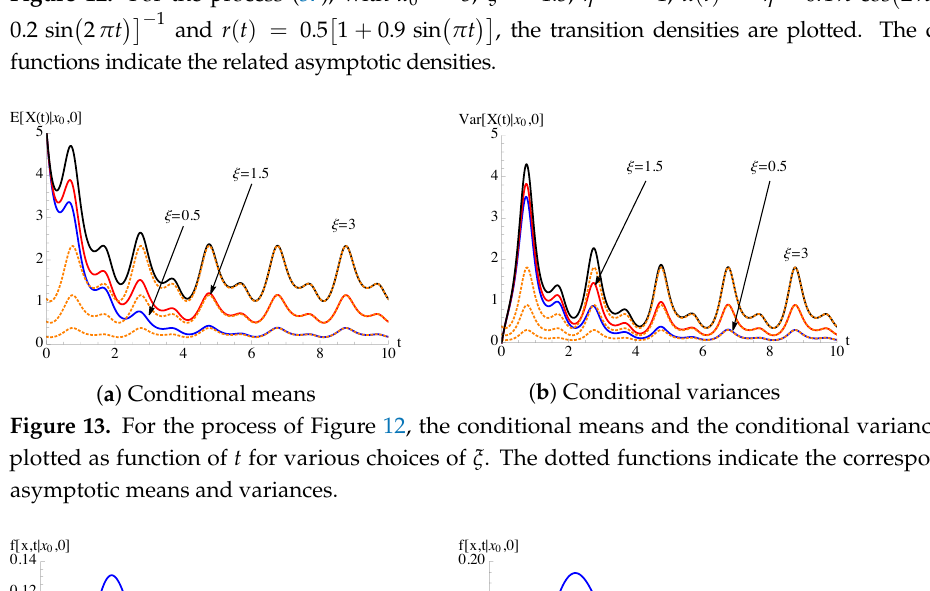
(cid:0) (cid:1)(cid:2) 2 π t 1 +